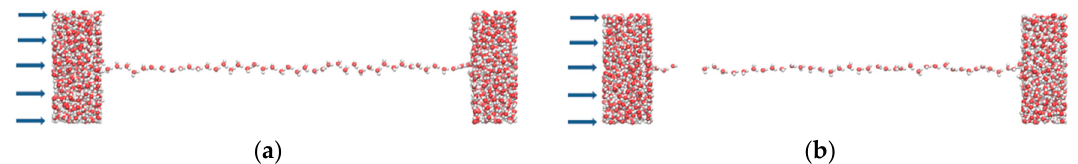
Figure 9. Visualization of water chain formed in-between two reservoirs: ( a ) perfect CNT and ( b ) CNT with Z-distortion value 1.2.